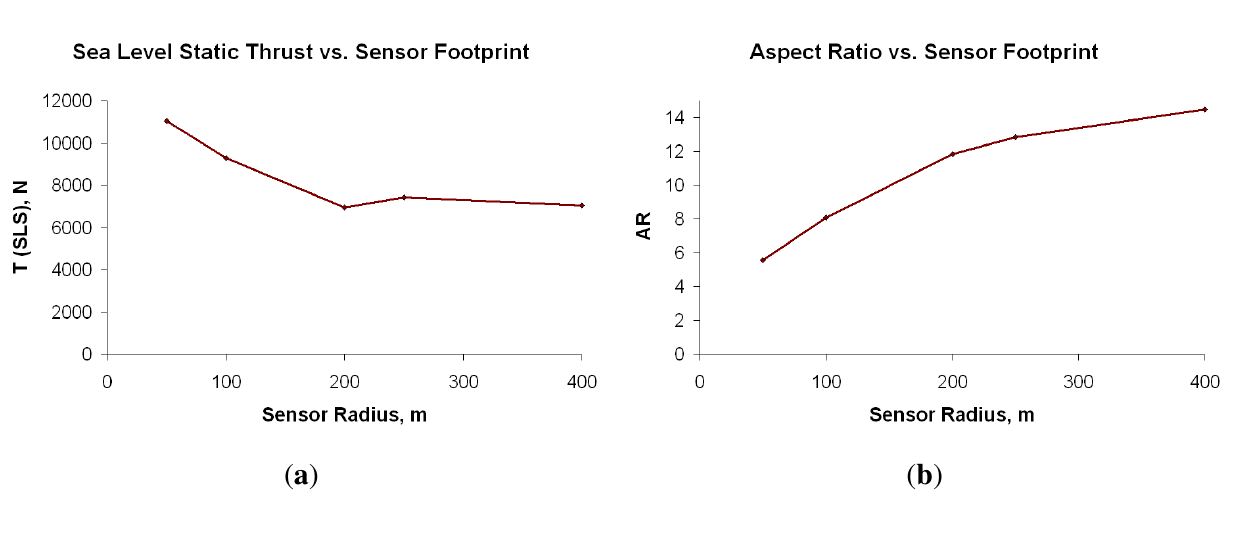
Figure 24. Sample results of design study—the thrust and aspect ratio requirements as function of the sensor footprint. ( a ) Thrust; ( b ) Aspect